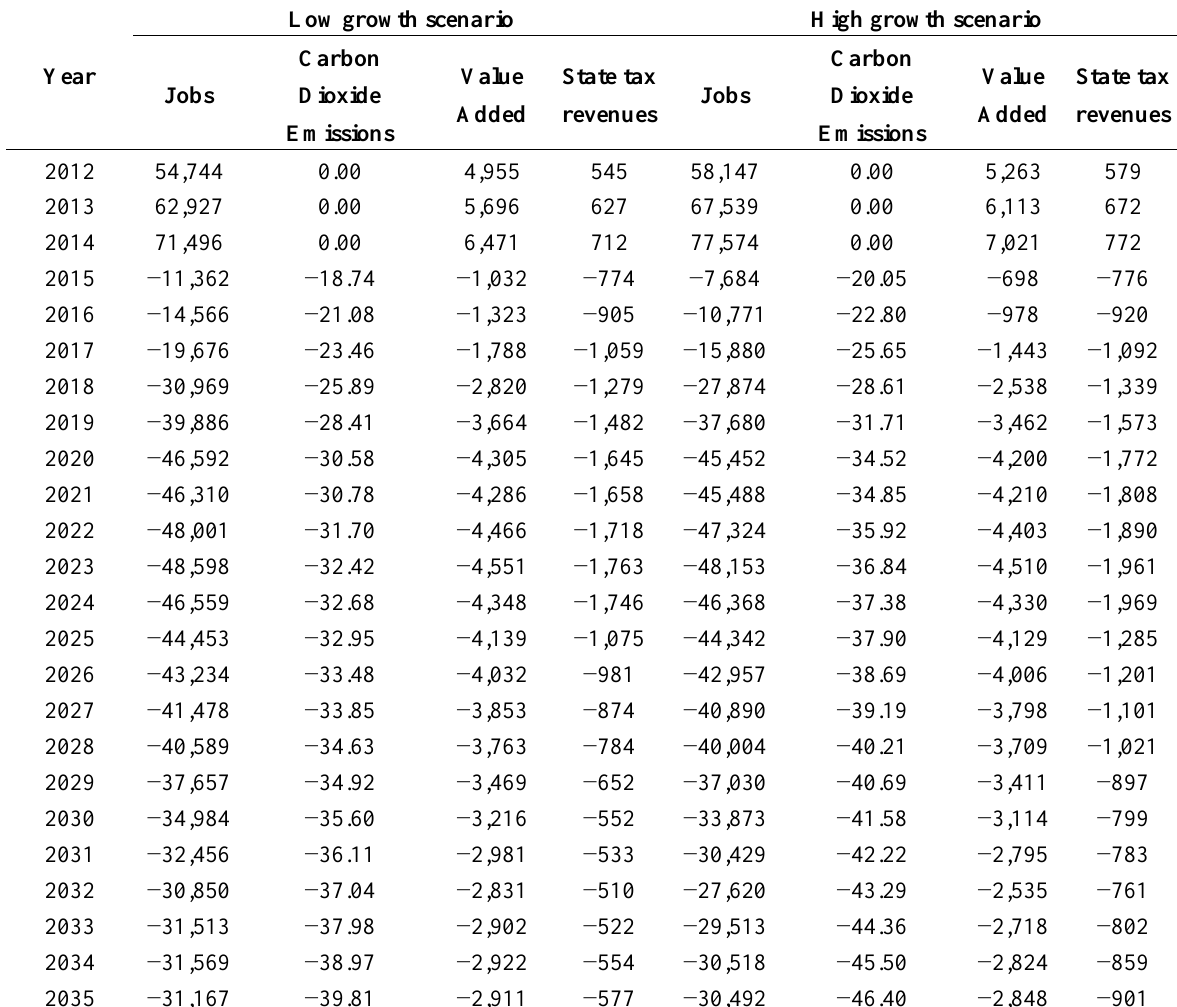
Table 3. Net economic and environmental impacts from RPS